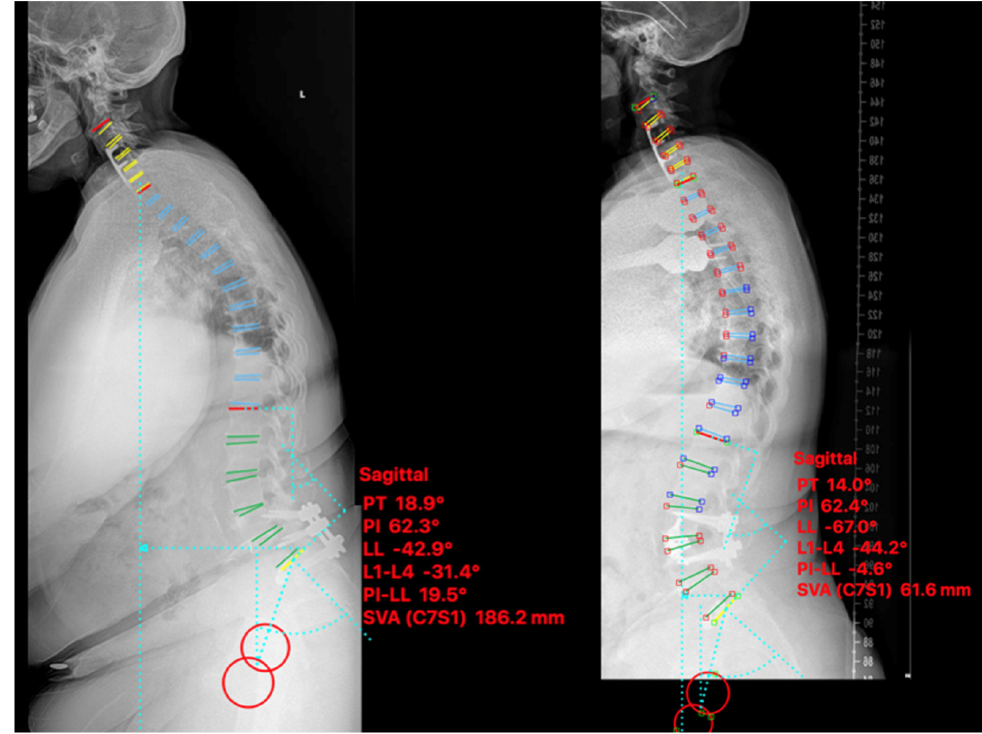
Figure 3. Case I. Pre-psoas interbody fusion for L3-4 spondylolisthesis with anterior column release and with an expandable 30° cage. Lateral standing scoliosis radiographs. Pre-operative imaging ( left ), 6-months postoperative imaging ( right ).